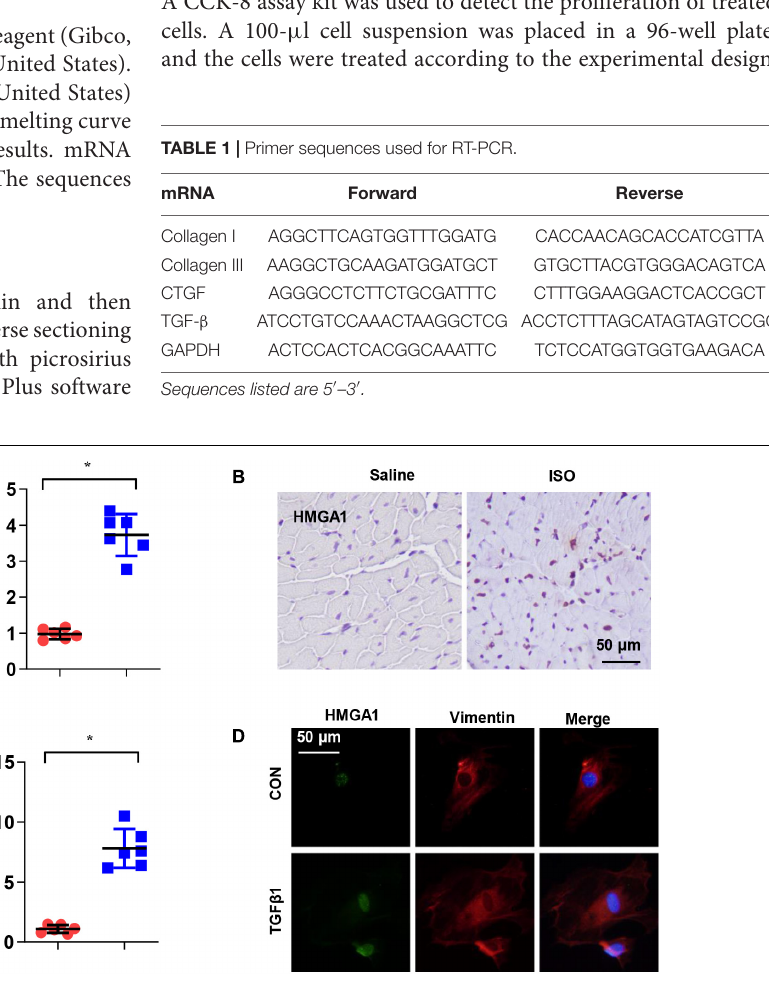
FIGURE 1 | High-mobility group A1 (HMGA1) was upregulated during cardiac fibrosis. (A) The protein level of HMGA1 in mouse hearts after isoproterenol (ISO) insult ( n = 6). (B) Immunohistochemical staining of HMGA1 in mouse hearts after ISO insult ( n = 5). (C) The protein level of HMGA1 in fibroblasts after transforming growth factor- β 1 (TGF β 1) insult ( n = 6). (D) Immunofluorescence staining of fibroblasts after TGF β 1 insult ( n = 5). * p < 0.05.